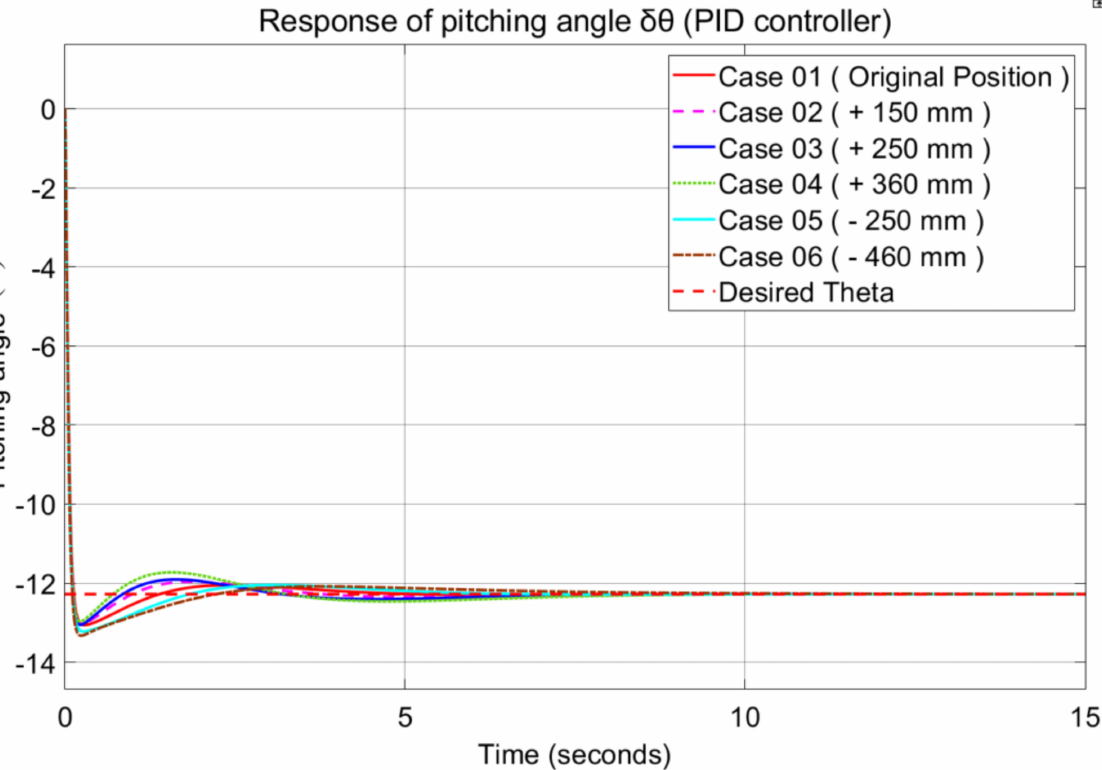
Figure 20. Response of the pitching Angle ( δθ ) with